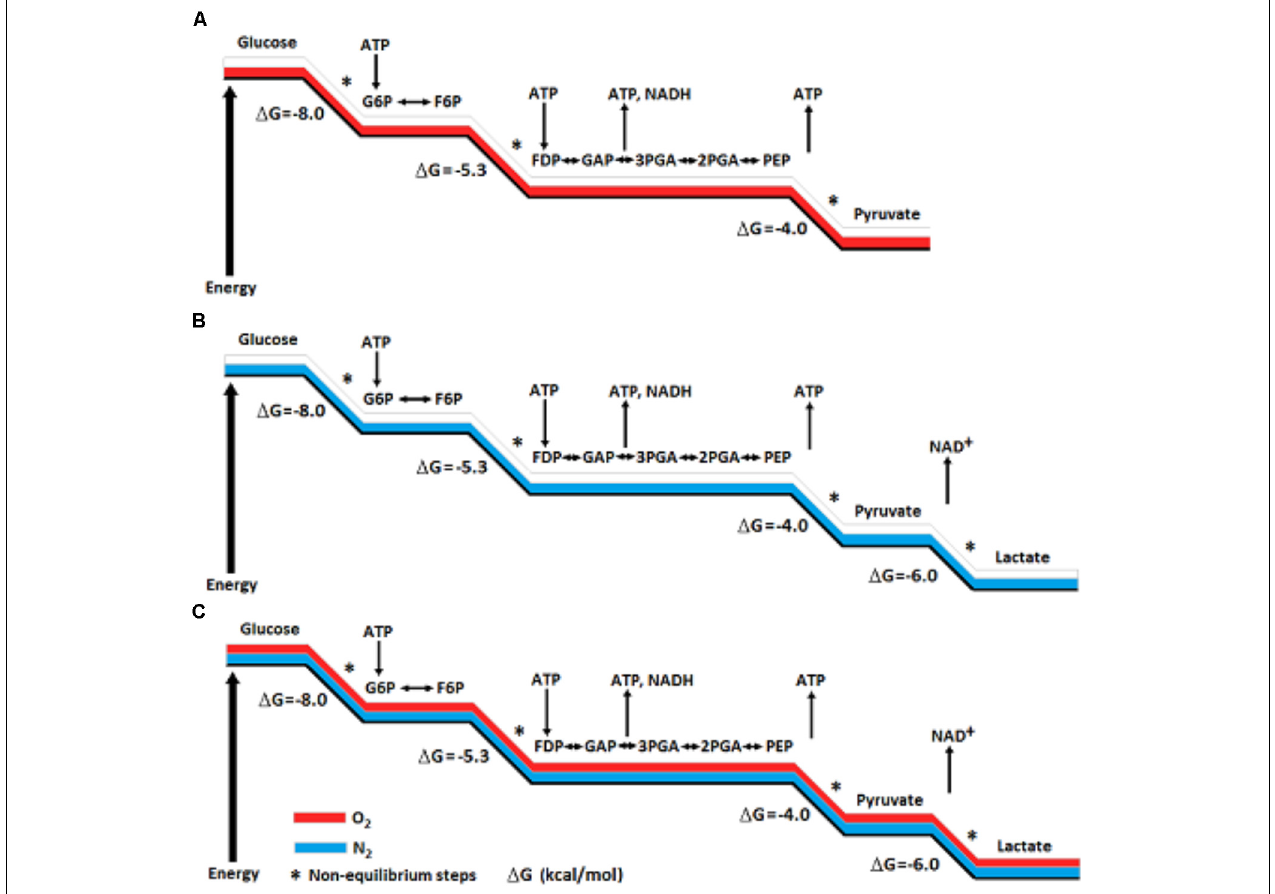
FIGURE 2 | A Schematic presentation of potential free-energy change profile of aerobic glycolysis (A) and of anaerobic glycolysis (B) . The potential free-energy change of pyruvate conversion to lactate dictates that this reaction should proceed regardless of the oxygenation conditions (C) . The conversion of pyruvate to lactate also assures the continuous supply of NAD + , an essential component for the cyclical nature of the glycolytic